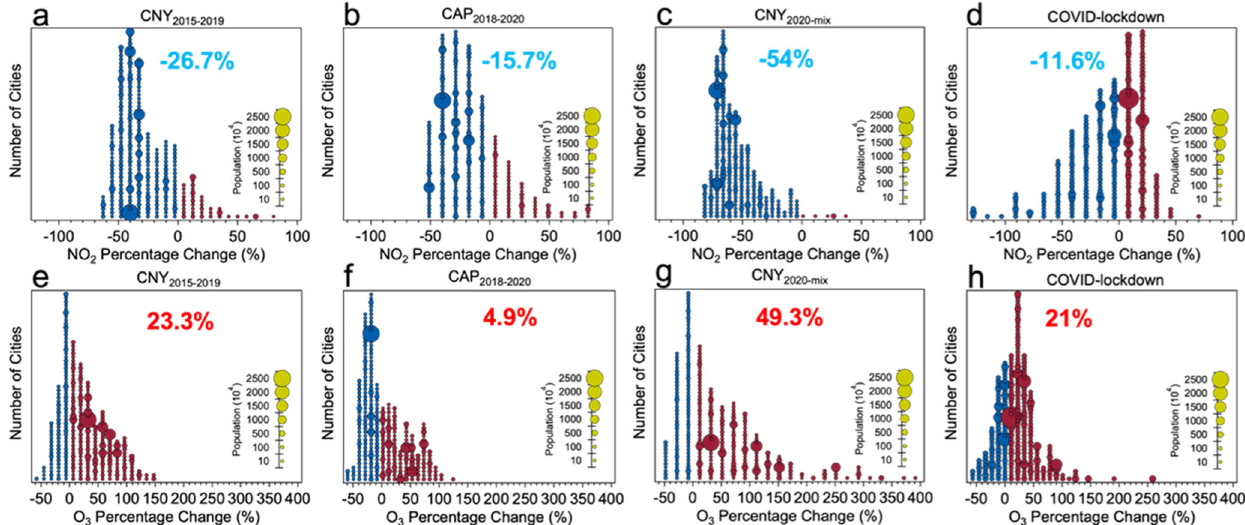
Fig. 2 City number distributions of pollutant changes for anthropogenic drivers. The drivers include the CNY 2015 – 2019 (Chinese New Year) effect for NO 2 ( a ) and O 3 ( e ), the CAP 2018 – 2020 (Clean Air Plan) effect for NO 2 ( b ) and O 3 ( f ), the CNY 2020-mix effect for NO 2 ( c ) and O 3 ( g ), and the COVID-lockdown effect for NO 2 ( d ) and O 3 ( h ) in each city across China. Red solid circles represent cities with increased percentages, blue solid circles represent cities with decreased percentages. The size of the circles represents each city ’ s